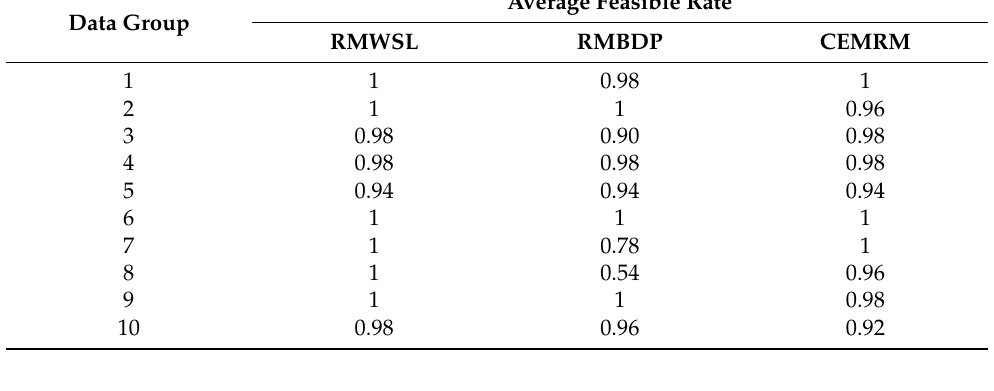
Table 3. Average feasible rate.